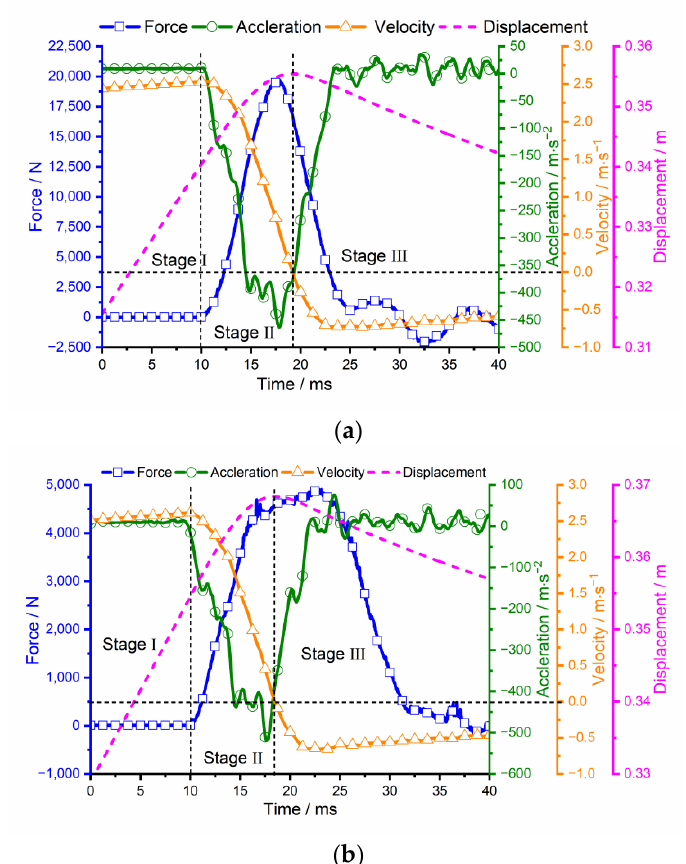
Figure 12. Drop-weight test results of the battery module at Z− directions. ( a ) Test results at Z3− position; ( b ) Test results at Z4− position.